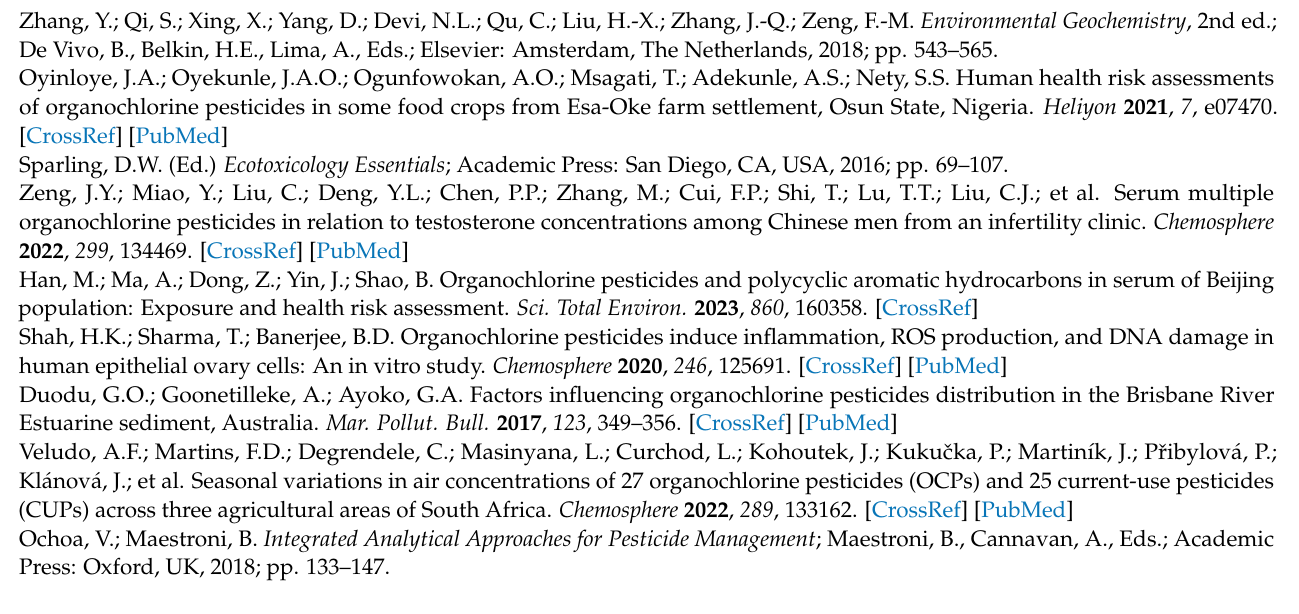
Table S2: Standard curves and detection limits of 15 organochlorine pesticides; Table S3: Linear regression equation analysis of soil index and